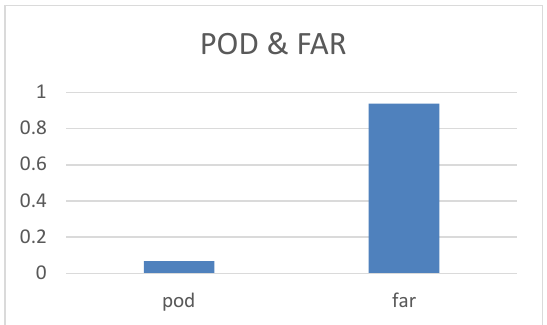
Figure 5. POD and FAR of all cases.